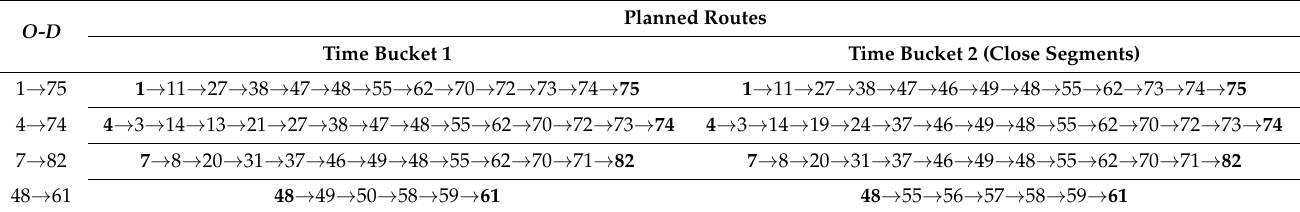
Table 10. Planned Routes Given Some Close Segments.